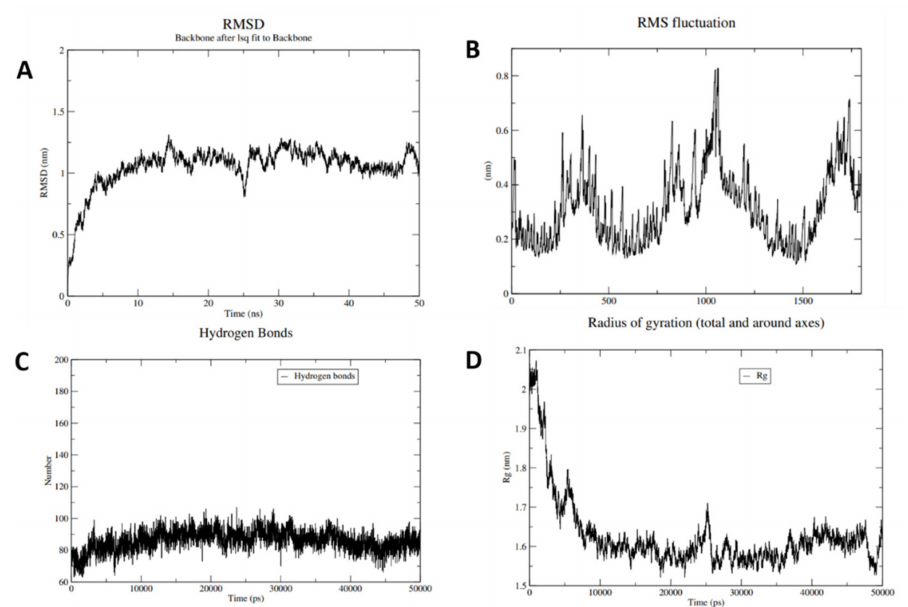
Figure 5. Molecular dynamic simulation of construct V6. ( A ) Root mean square deviation (RMSD) of protein backbone. ( B ) Root mean square fluctuation of vaccine molecule. ( C ) Hydrogen bonds of vaccine construct. ( D ) Plot of radius of gyration for V6.